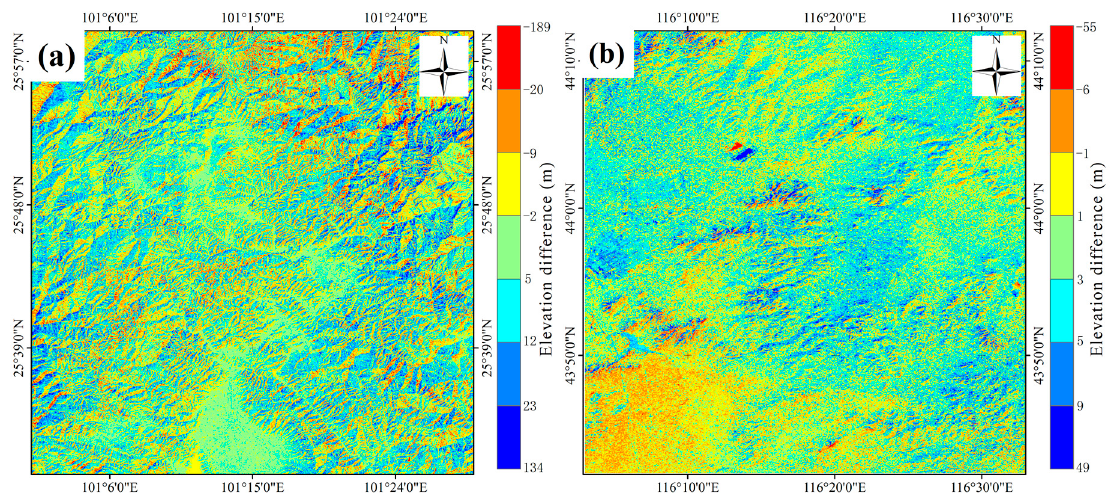
Figure 9. Illustration of the elevation difference between the AW3D30 and SRTM-1 in ( a ) the mountainous area, and ( b ) the low-relief area.